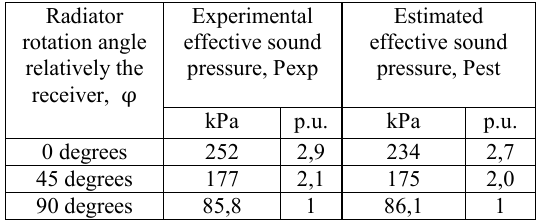
Table 1. The measurement results for several rotation angles of the radiator